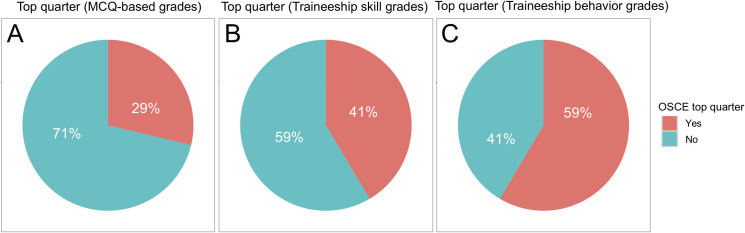
Proportion of students ranked in the top quarter based on fourth-year teaching unit grades who were ranked within the top quarter of OSCE grades (average of OSCE #1–3).(A) Multiple-choice question (MCQ)-based examination grades (fourth-year average). (B) Traineeship skill grades (fourth-year average). (C) Traineeship behavior grades. There was a significant difference between the three proportions (P<0.001, Chi-square test).